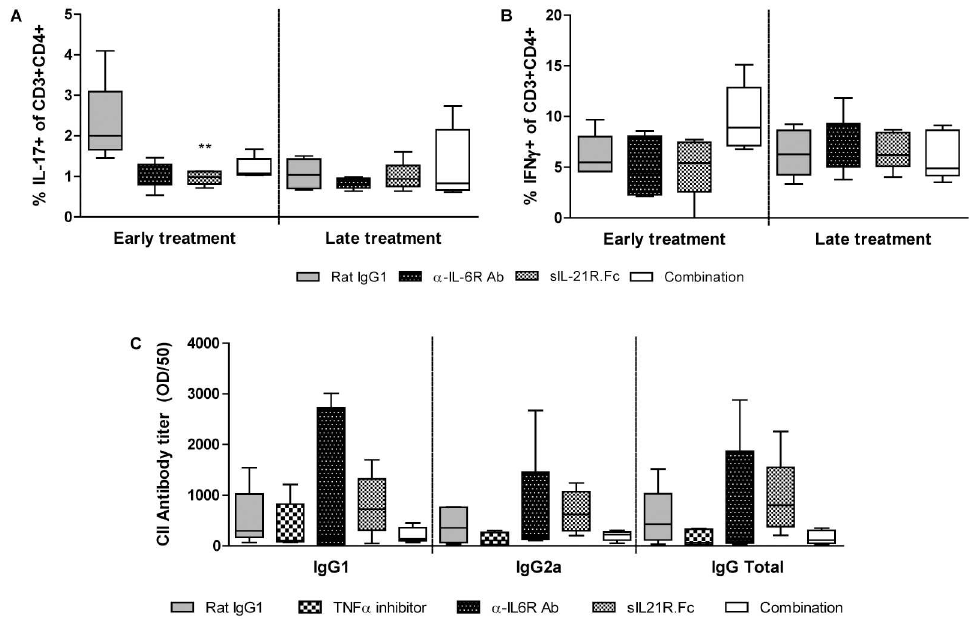
Fig 4. Effect of anti-IL-6 and/or anti-IL-21 treatment on Th17, Th1, and antibody development in CIA mice. Th17 (A) and Th1 (B) levels in draininglymph nodes as measuredusing flow cytometry, and anti-CII antibodylevel in serum (C) as measuredby ELISA of mice with CIA receivinganti-IL-6 and/or anti-IL-21 treatment. n = 5/group; ** p < 0.01versus Rat IgG1; A+C—Kruskal-Wallis, B—One-way ANOVA.